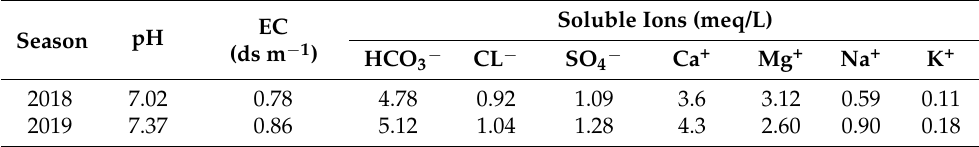
Table 3. Chemical properties of irrigation water at the experimental site in 2018 and 2019